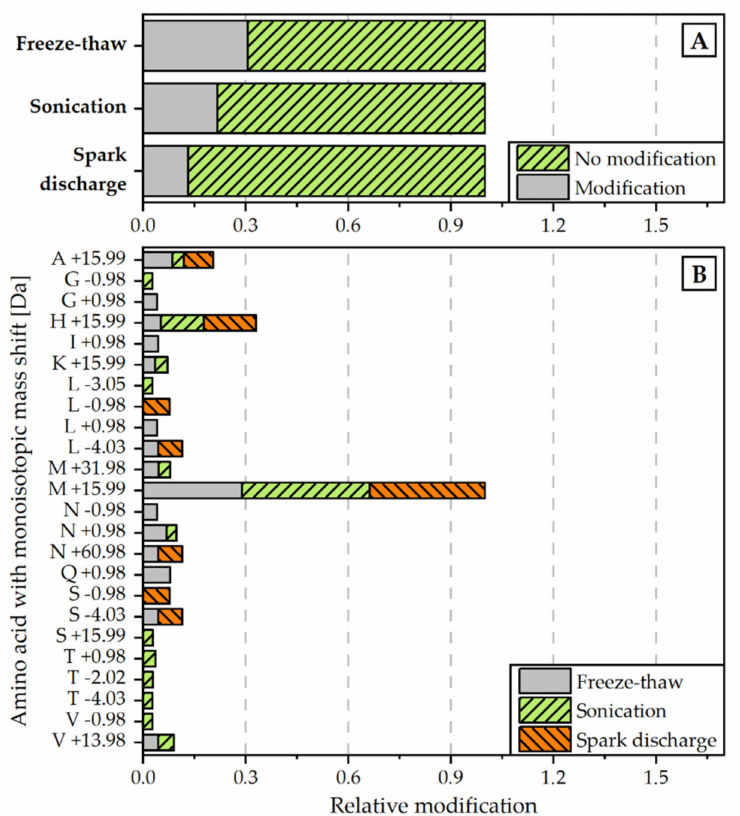
Figure 5. Relative amount of modifications detected for each disintegration method (normalized to all peptide spectrum matches) ( A ) and monoisotopic mass shifts [Da] for specific amino acids (normalized to overall amount of M +19.99 modification) ( B ). Modifications were scanned with the Byonic Version 3.6.0 from Proteome Discoverer ® 2.4. Detected modifications were filtered with a Byonic Score > 250 and Delta Mod Score >